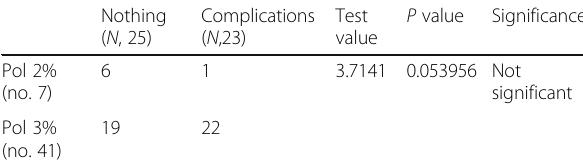
Table 10 The correlation between the polidocanol concentration injected and the